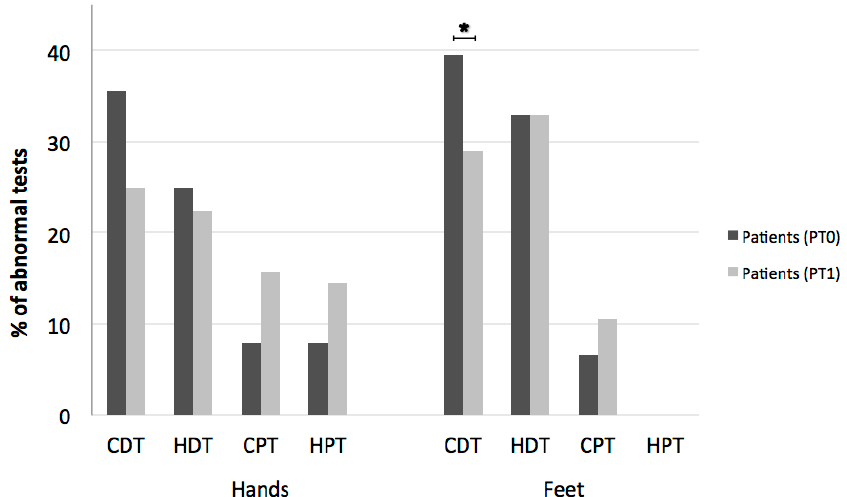
Figure 4. Percentages of abnormal Quantitative Sensory Testing for hands and feet in patients before (PT0) and after (PT1) THC/CBD therapy. A significant reduction in abnormal cold detection threshold (CDT) after Sativex ® is found in feet and a trend towards a reduction in abnormal CDT is also found in hands. *: statistically significant.